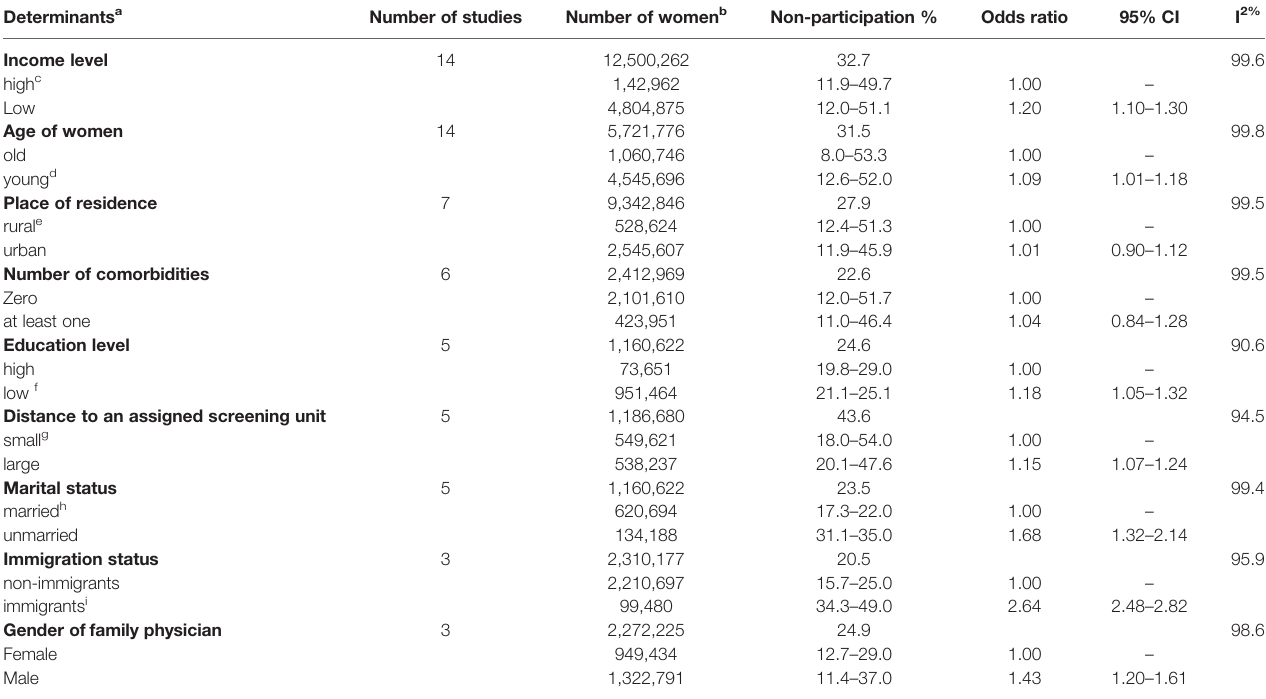
TABLE 2 | Summary of determinants of screening non-participation in breast cancer screening programs. Determinants a